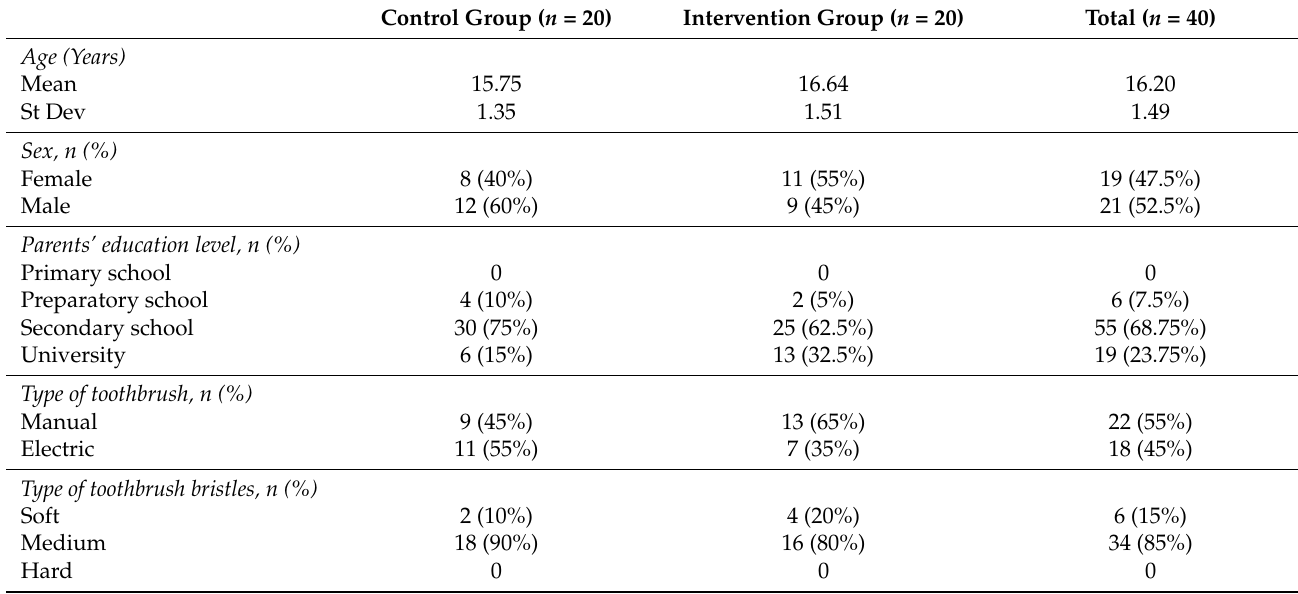
Table 1. Baseline characteristics of the participants recruited.